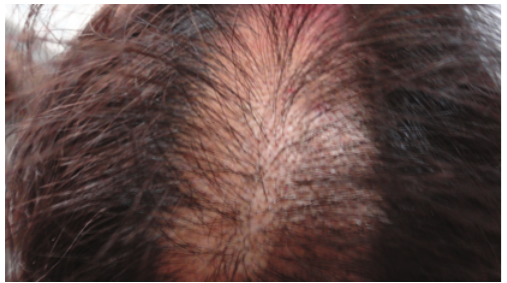
Figure 2: Dermatitis artefacta lesions on the bilateral feet.